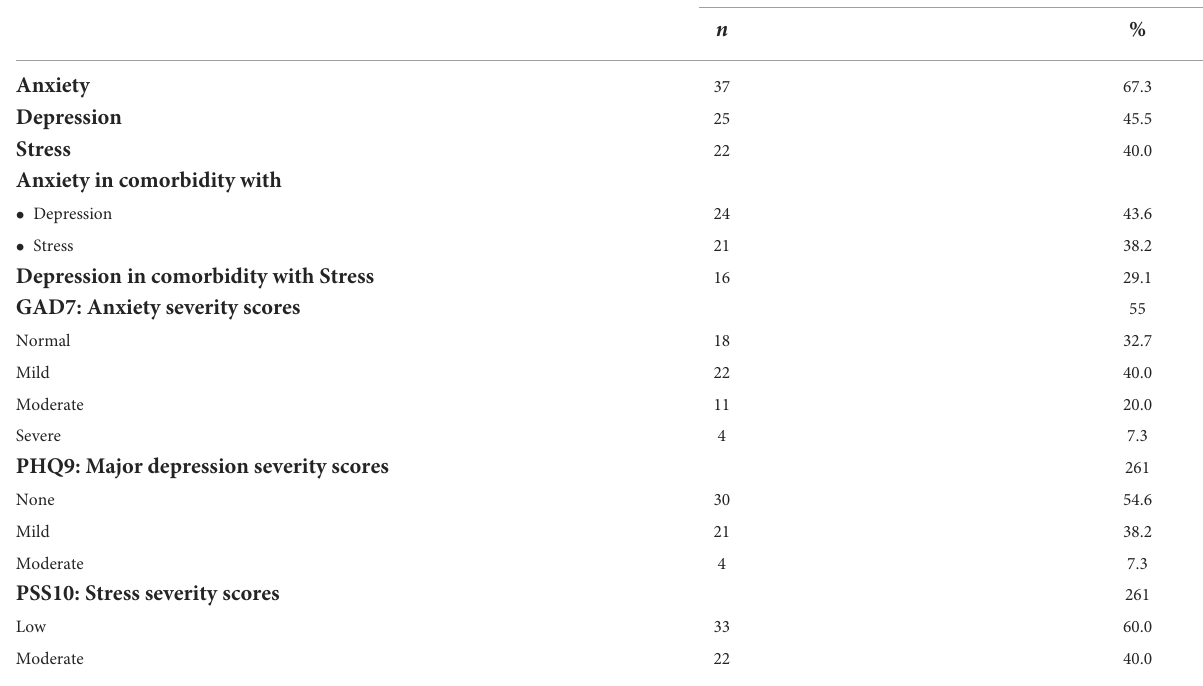
TABLE 2 Frequency and severity of depression, anxiety, and stress in the